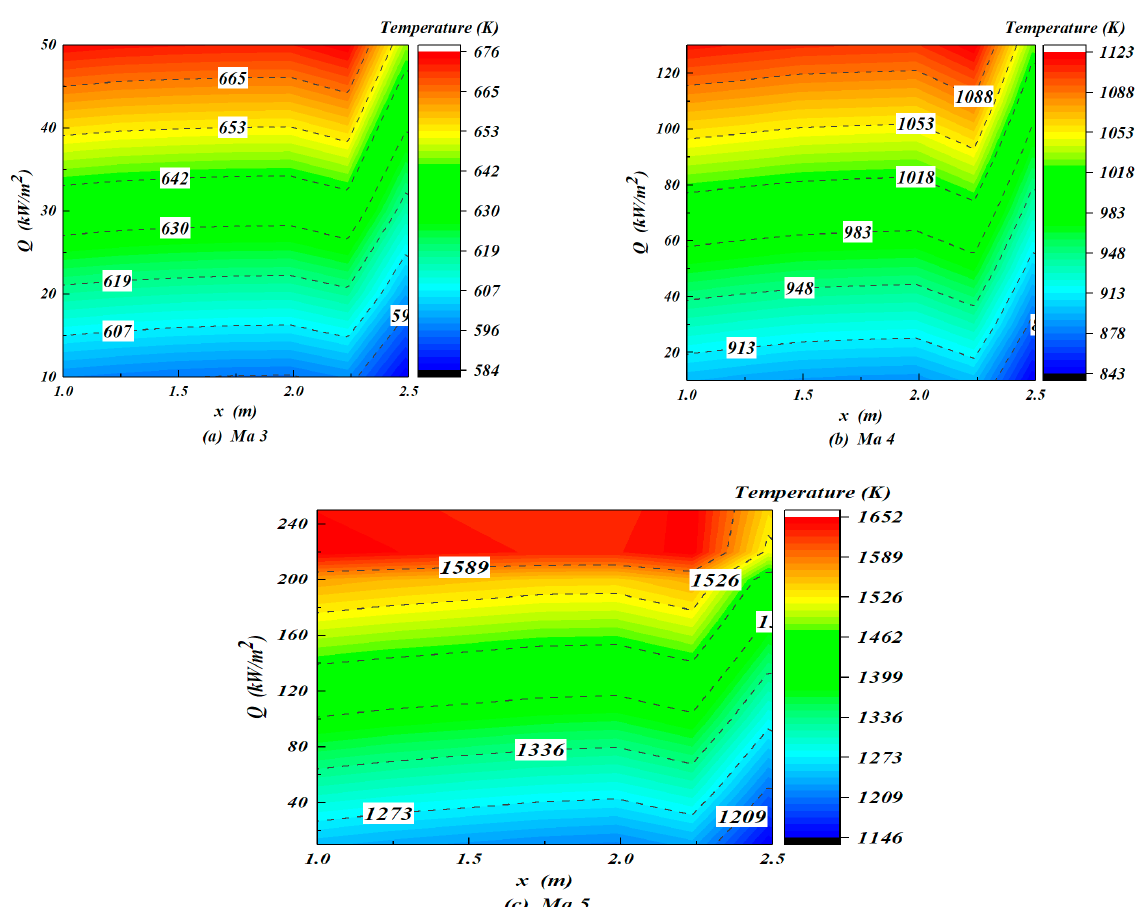
Figure 13. The heat equilibrium temperature changes with the heat dissipation capacity Q at the low-temperature region along x/L : ( a ) Ma 3; ( b ) Ma 4; ( c ) Ma 5.